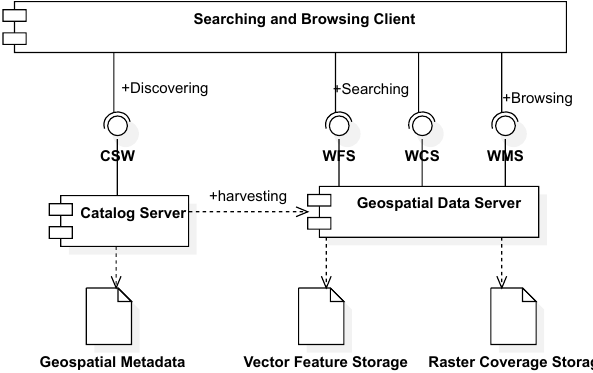
Figure 10. Illustration of geospatial data discovering, search and browsing in OGC Spatial Data